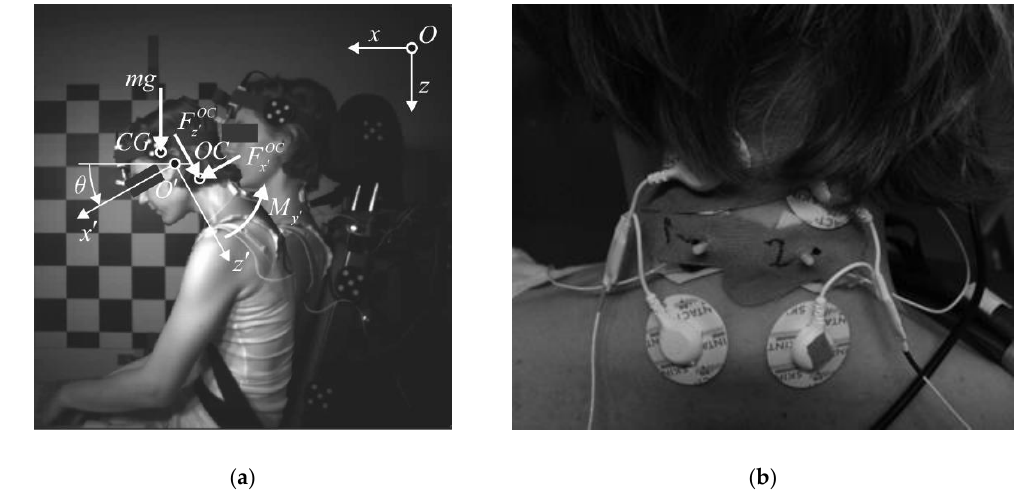
Figure 1. Experiment setup: ( a ) Volunteer seated on the sled from the high-speed camera point of view. The volunteer’s initial position and position during impact, and the head-neck free body diagram are depicted; ( b ) Surface EMG electrodes and MC sensors placed on the upper trapezius.